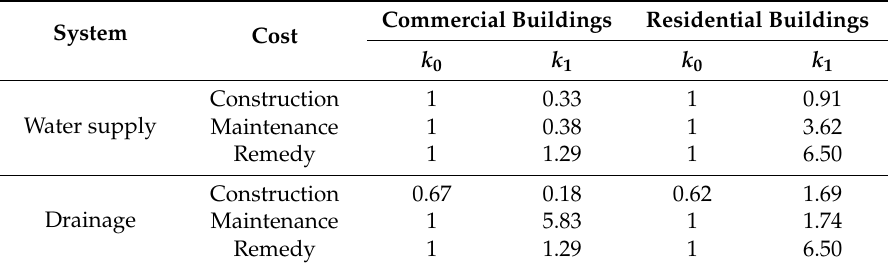
Table 5. Constants k 0 and k 1 for water systems in buildings.